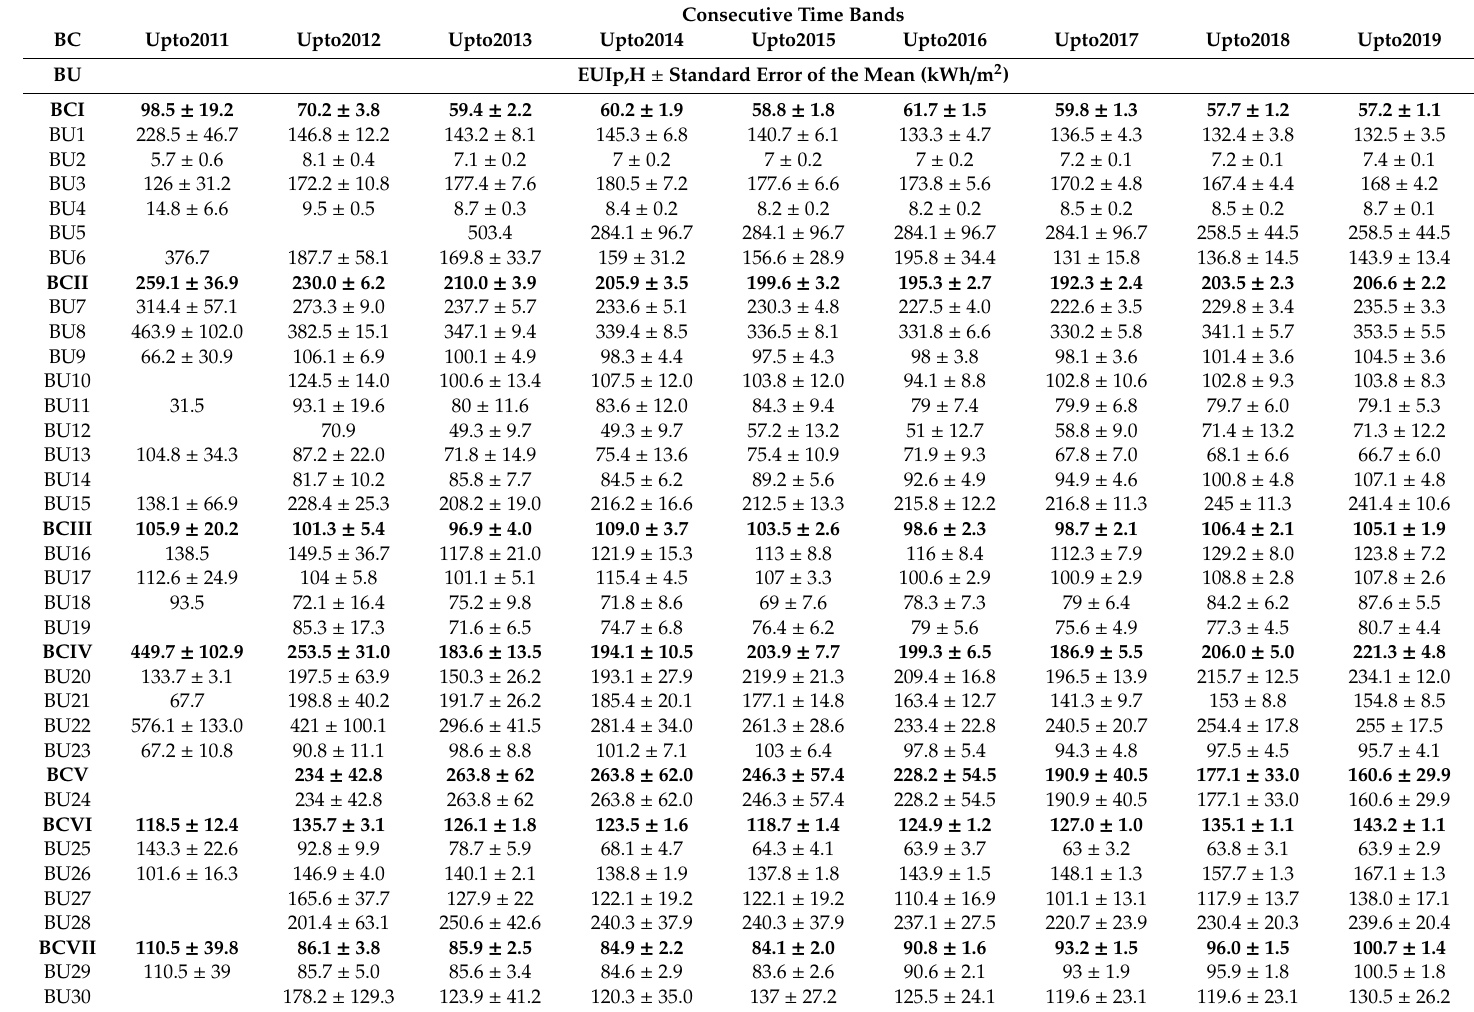
Table 3. Time evolution of calculated average primary energy use for space heating for the di ff erent building categories and building uses in the NR